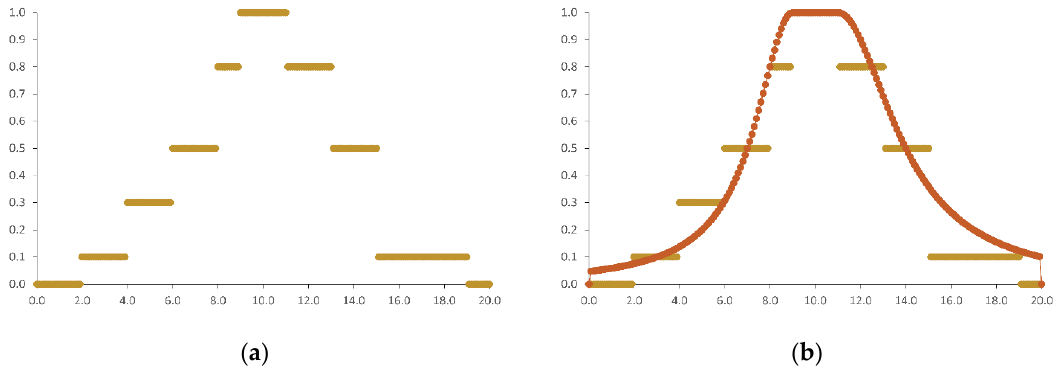
Figure 3. ( a ) Membership function representation of a Standard Boolean Analytical Hierarchy Process framework; ( b ) A sinusoidal membership function that is fitted to an AHP membership function—Fitted Fuzzy Curve.